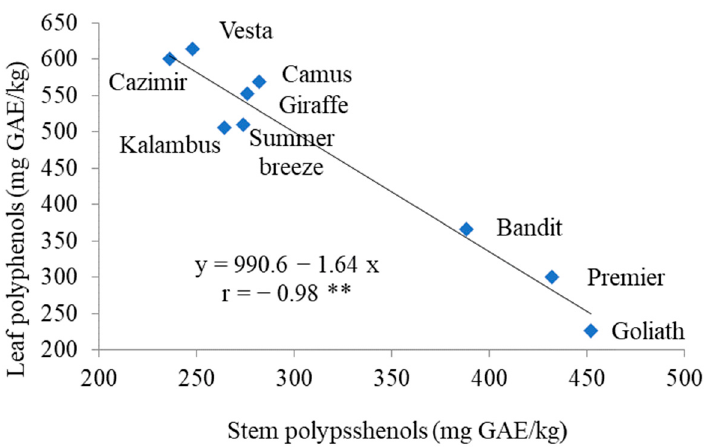
Figure 2. Correlation between leaf and stem polyphenol content.